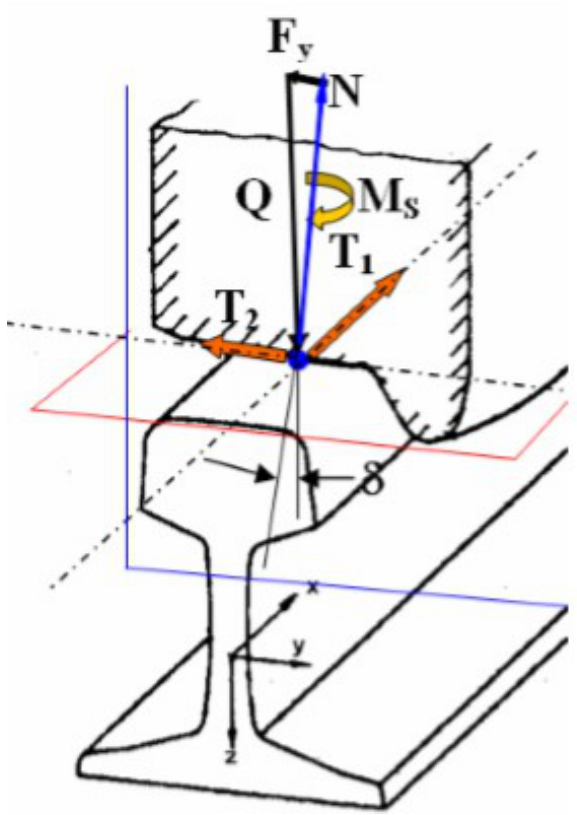
Figure 9. Visualization of fundamental model parts